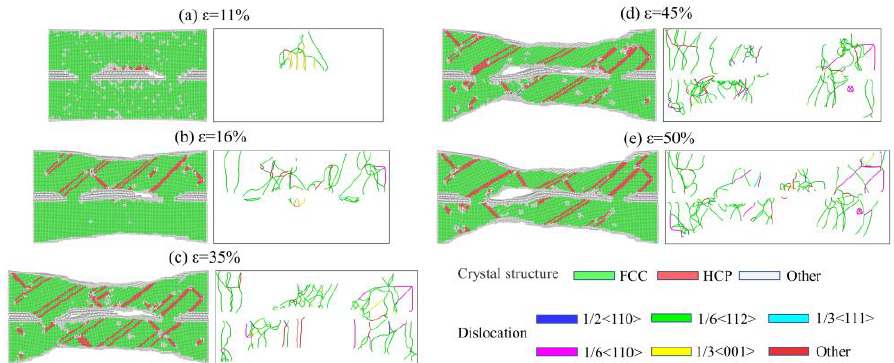
Figure 18. Stress distribution of Gr/Cu-2 under different strains. ( a ) ε = 11.5%, ( b ) ε = 16%, ( c ) ε = 35%, ( d ) ε = 50% and ( e ) ε = 65%.